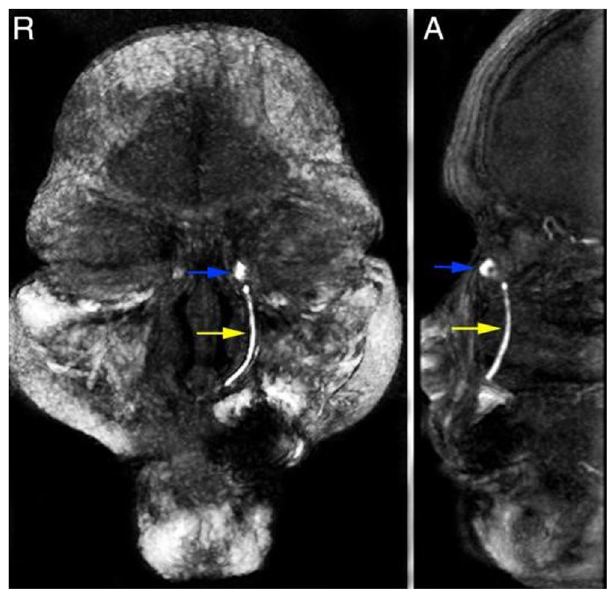
Figure 5. The MRI after RSHSI. The bule arrow represents the lacrimal sac. The yellow arrow marks the Spherical Headed Silicone Tube. R, Right; A,